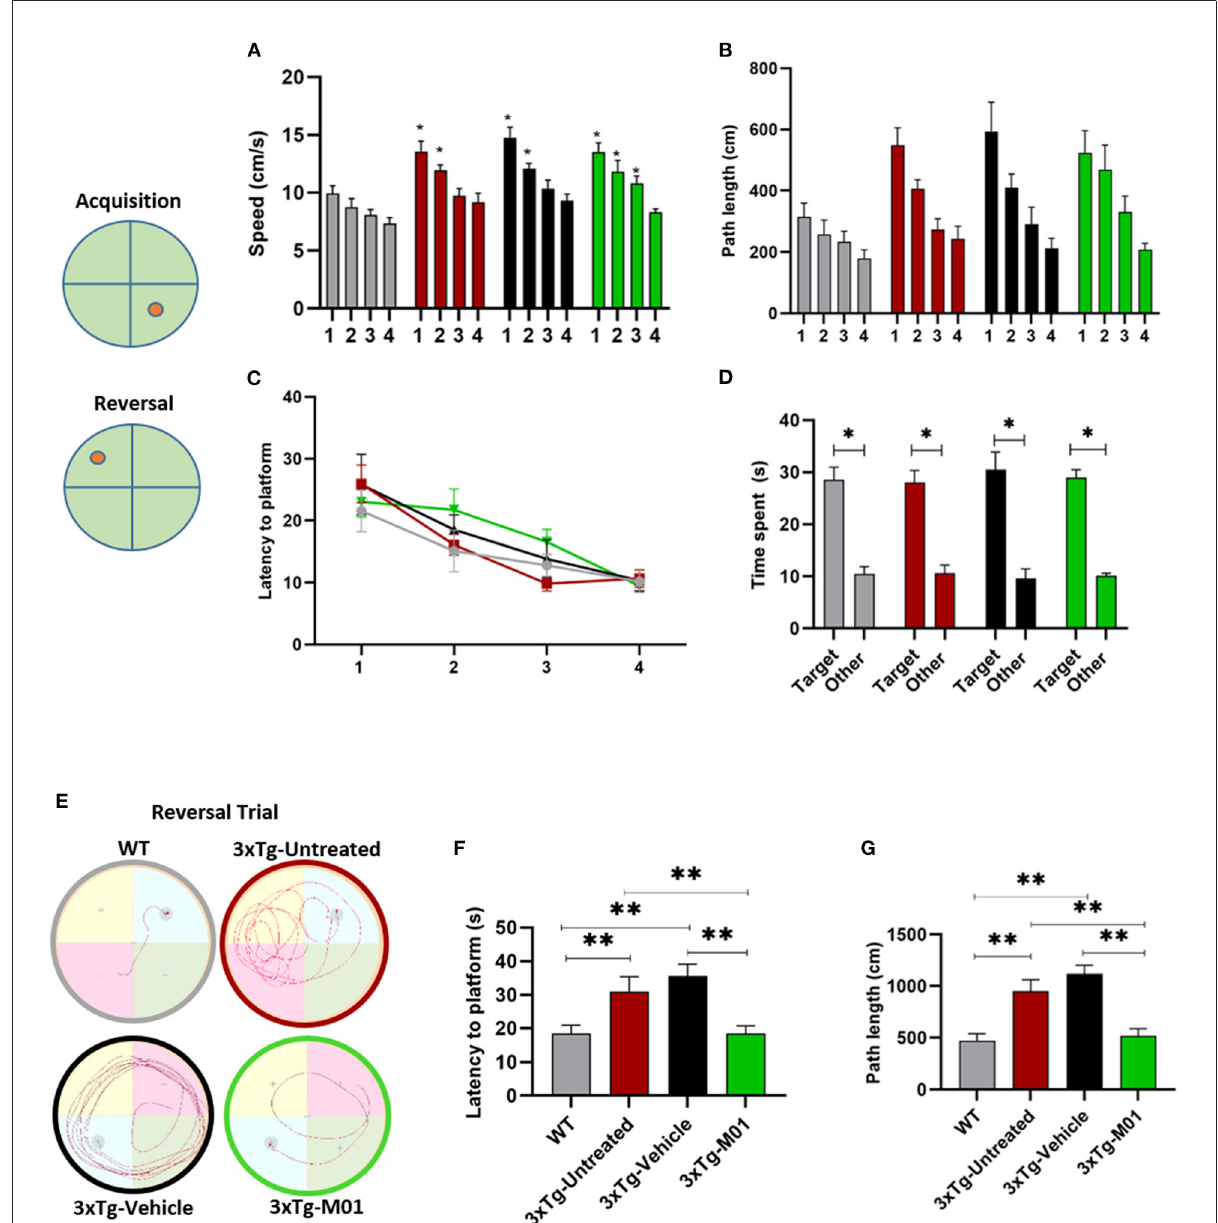
FIGURE2 M01 rescued working memory and reversal learning deficits in 3xTg-AD mice. Schematic representation of the platforms during acquisition and reversal trials. (A) swimming speed during the hidden platform training days, a significant decrease in the swimming speed was recorded throughout the training days in 3xTg- untreated, -vehicle, and M01 groups. (B) path length, and (C) latency to reach the platform during hidden platform days also decreased over the training days. (D) Time spent in the platform quadrant during the probe test by each group. All groups spent a significantly longer time in the target quadrant. A reversal trial was used to measure learning flexibility. (E) Trace diagram during the reversal trial (F) latency to reach the platform, and (G) path length during the reversal. WT and M01 treated 3xTg mice spent significantly less time finding the platform. The results are plotted as mean ± SEM. * p < 0.05, ** p < 0.01, n = 8–12/group. Repeated measures ANOVA followed by Tukey’s post hoc test were used to compare between groups.